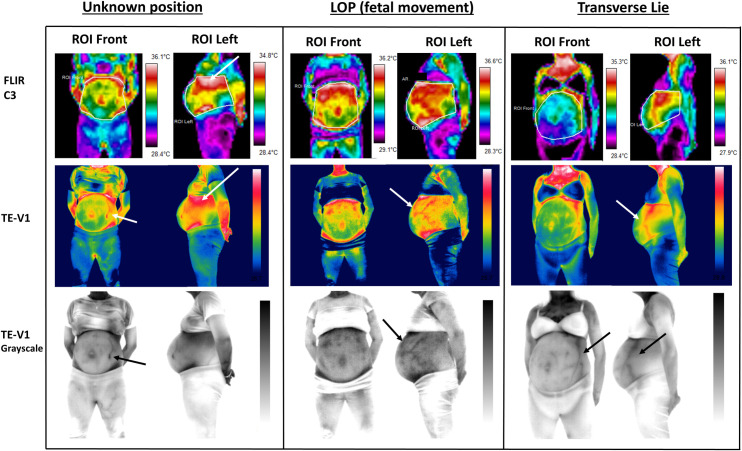
Qualitatively analysed thermal images of: a) One women who experienced fetal movements during and after the procedure, and therefore couldn’t describe or located the position of the fetus (Unknown position), b) One women who experienced fetal movements only during the procedure, and after the end of the procedure could describe the position of her fetus as LOP, and c) One women whose fetus was in transverse lie and did not felt any movements during and/or after the procedure.